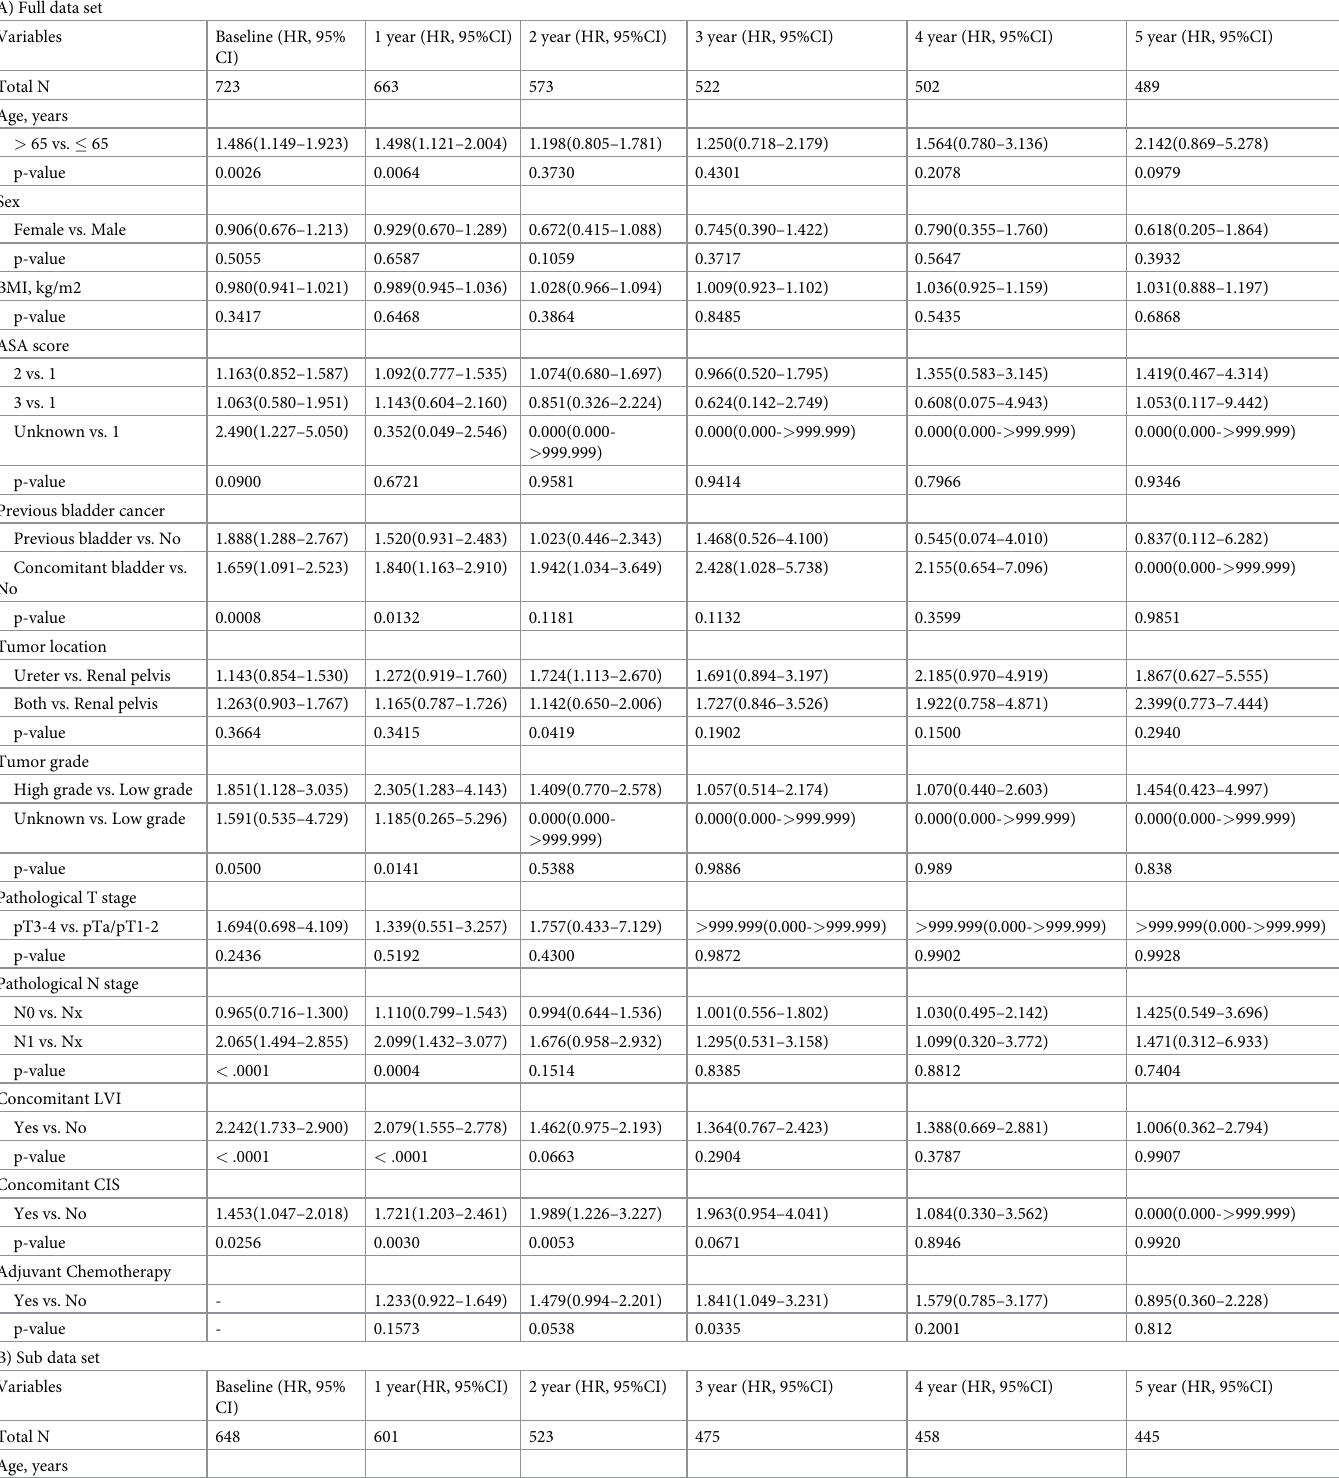
Table 2. Univariate analysis of risk factors for conditional overall survival during 5-year follow-up after radical nephroureterectomy (A) among all patients (N = 723), patients without previous history of bladder cancer only (N = 648), and (C) after propensity-score matching. A) Full data